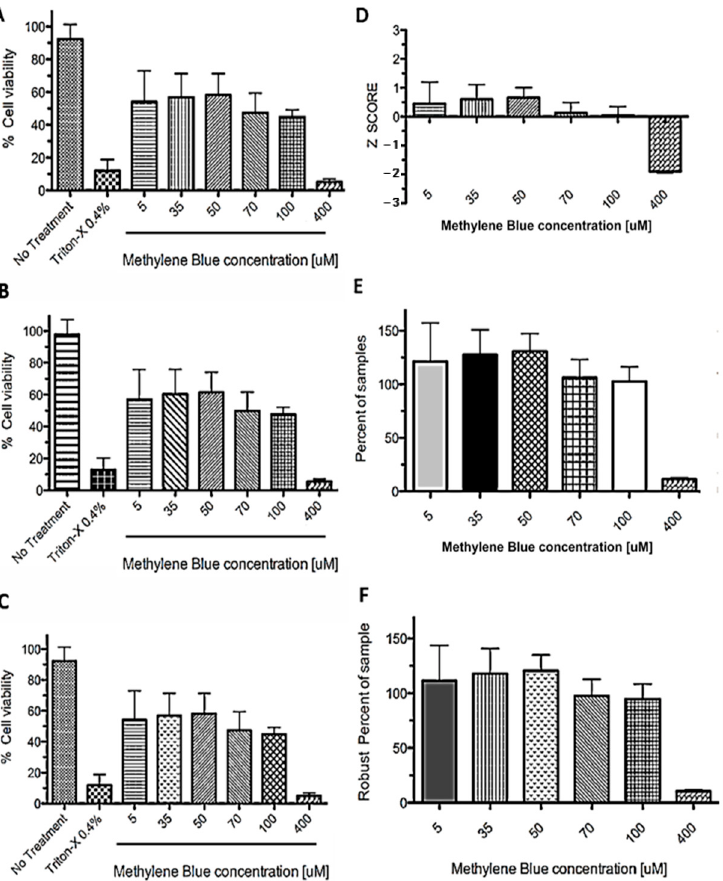
Figure 4. Data normalization methods applied to MTT assay after PDT. SHSY5Y cells were incubated in plates with different concentrations of methylene blue (MB) (from 5 to 400 µM) and then exposed to light for a 6 min treatment, then 0.75 mg/mL MTT was added (final concentration). The absorbance was measured after 3 h and the read in OD 570 values were normalized as: ( A ) Percent of control. ( B ) Percent of maximum OD 570 . ( C ) Percent of the median of control. ( D ) Z score. ( E ) Percent of samples. ( F ) Robust percent of samples. Data are expressed as mean ± SD. Graphs are representative of three independent experiments performed in triplicate.